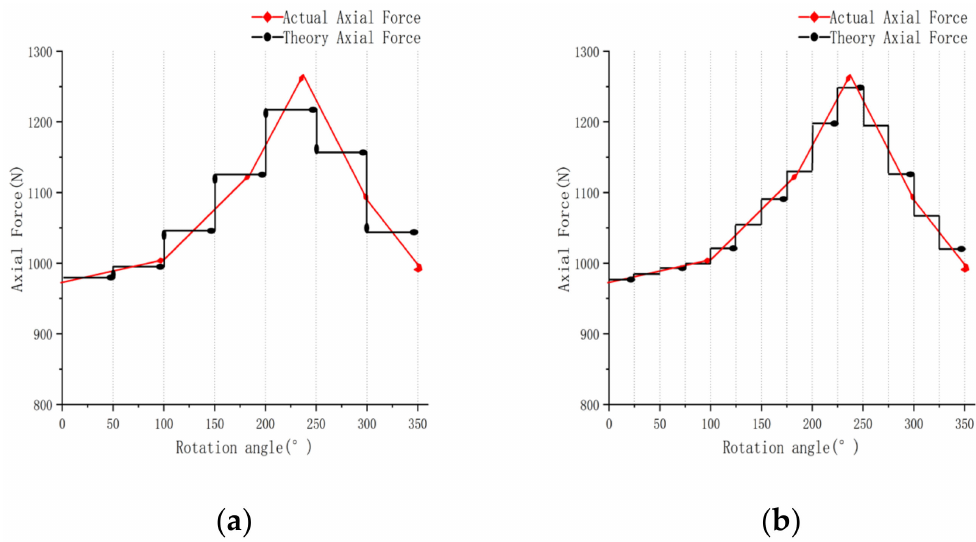
Figure 9. Tracking results of ideal different partition numbers: ( a ) the number of probe trace zones is lower; ( b ) the number of probe trace zones is higher.